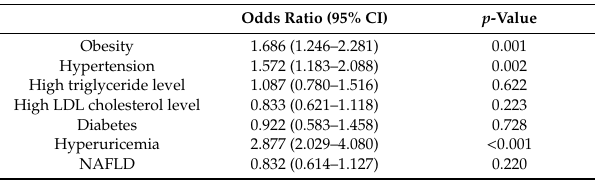
Table 4. Risk factors of chronic kidney